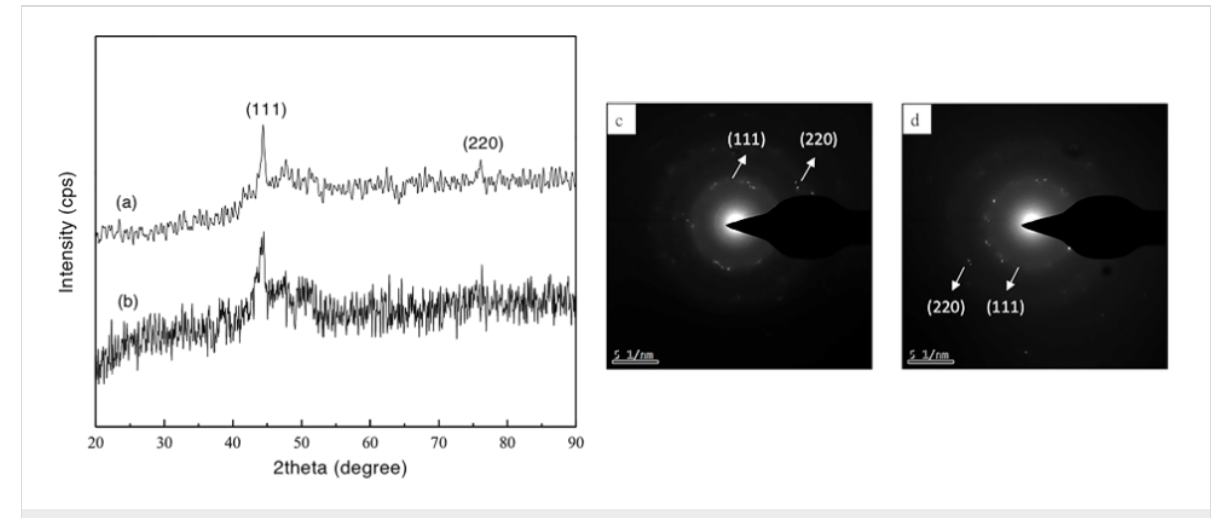
Figure 3: XRD patterns of cobalt nanowires prepared with PVP (a) and without PVP (b) under an external magnetic field. The corresponding SAED patterns of cobalt nanowires prepared with PVP (c) and without PVP (d).